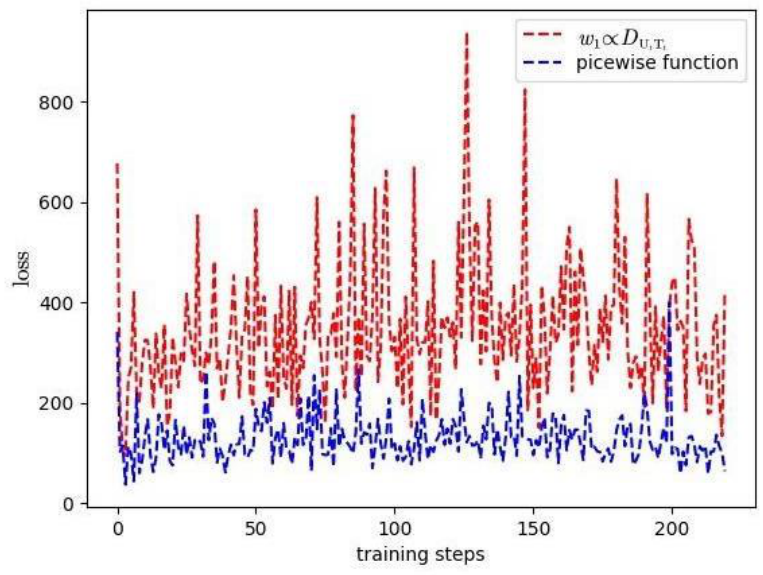
Figure 11. Comparison of loss with different forms of scale factors 2.